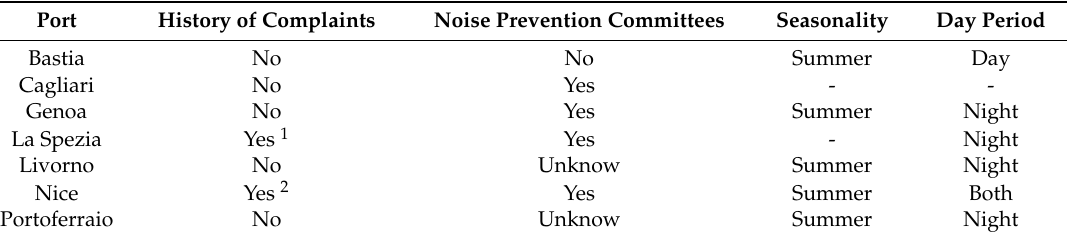
Table 7. Complaints and committees in the investigated ports.